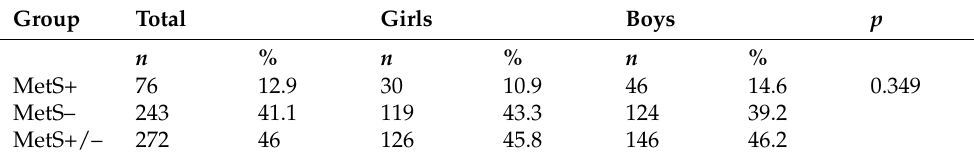
Table 3. Number of girls and boys in Groups I, II and III. Group